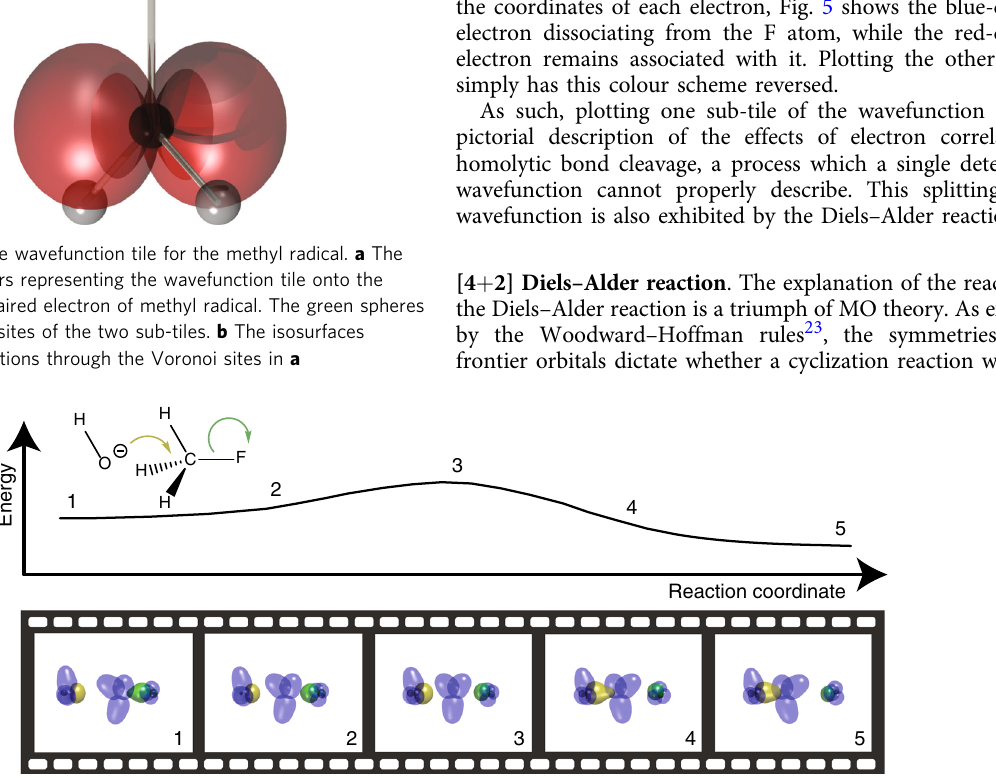
Fig. 3 Wavefunction tile cross-section isosurfaces of the progress of the S N 2 Reaction of FCH 3 + OH − → F − + CH 3